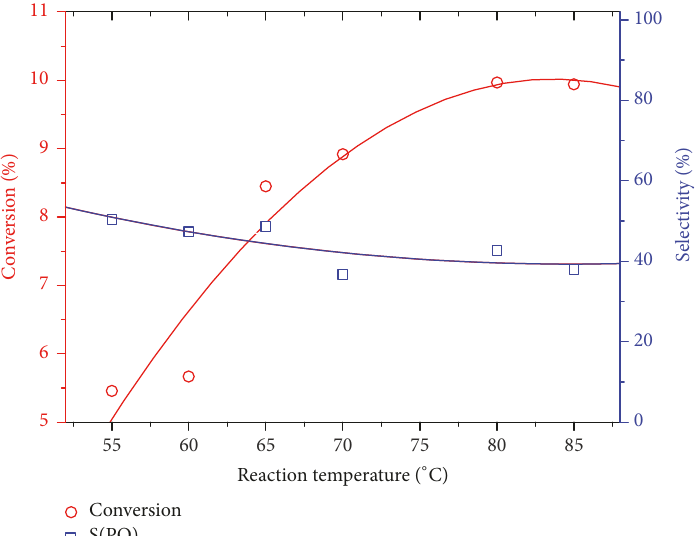
Figure 4: Effect of reaction temperature on the conversion and selectivity of PC over FePMo. Reactions carried out under 5-bar CO 2 pressure during a period of 7 h by using 0.150 g of catalyst and 0.050 g of TEABr (cocatalyst).